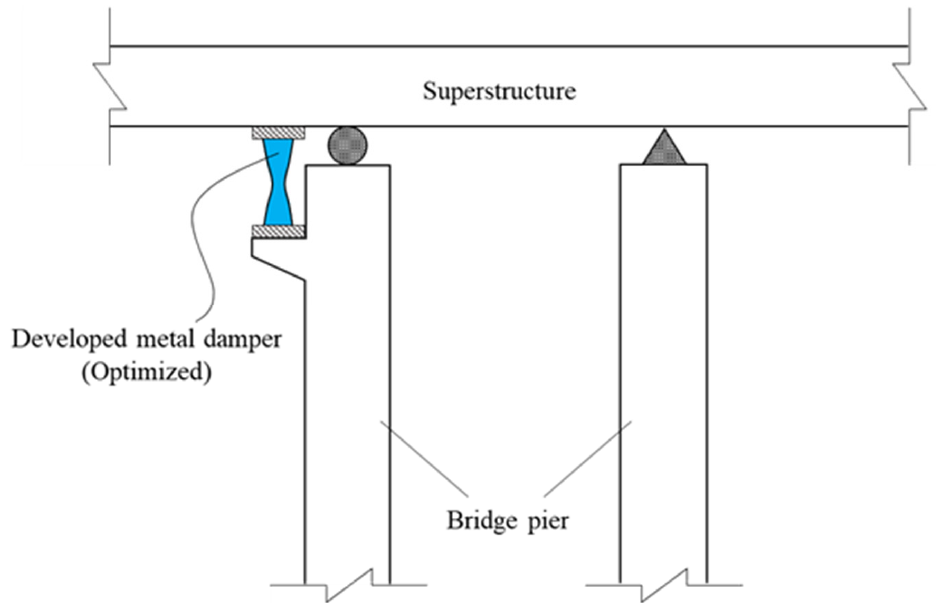
Figure 1. Conceptual installation of the proposed damper.